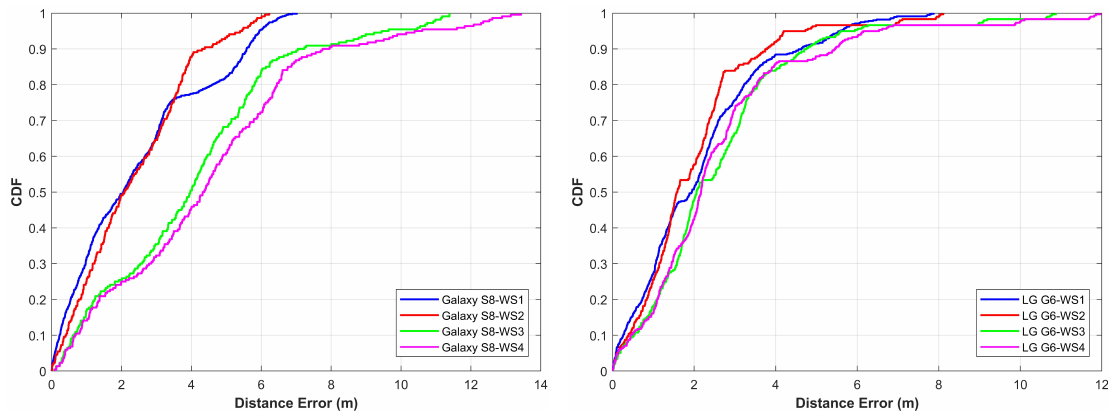
Figure 18. The cumulative distribution function (CDF) of Galaxy S8 and LG G6 for IACT